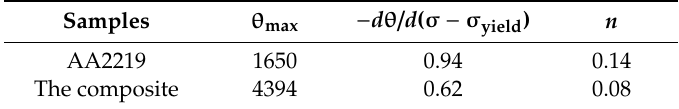
Table 4. Hollomon equation exponent ( n ) values and work-hardening parameters of AA2219 alloy and 5 wt.% nanosized TiB 2 /AA2219 composite.